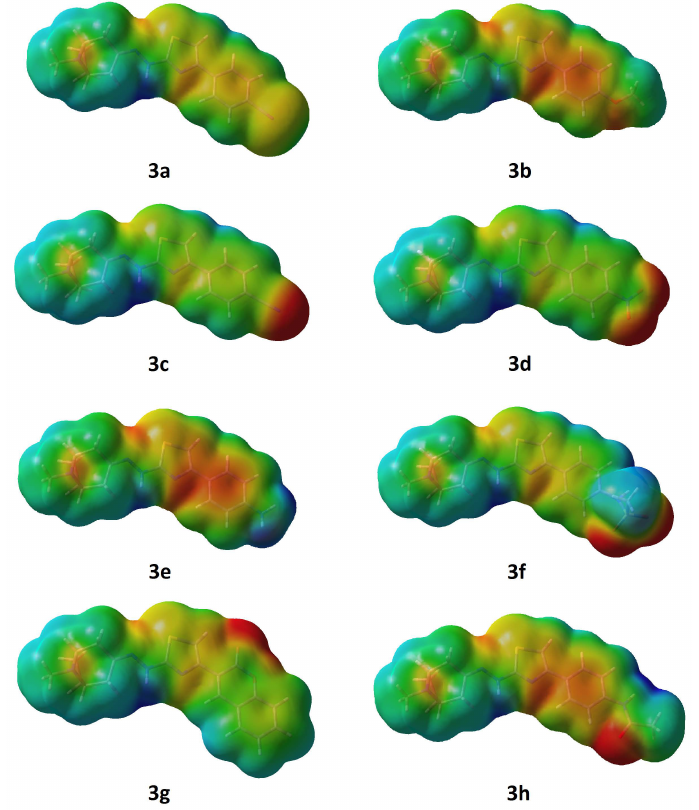
Figure 2. Molecular electrostatic potential (MEP) surface for compounds 3a – 3h